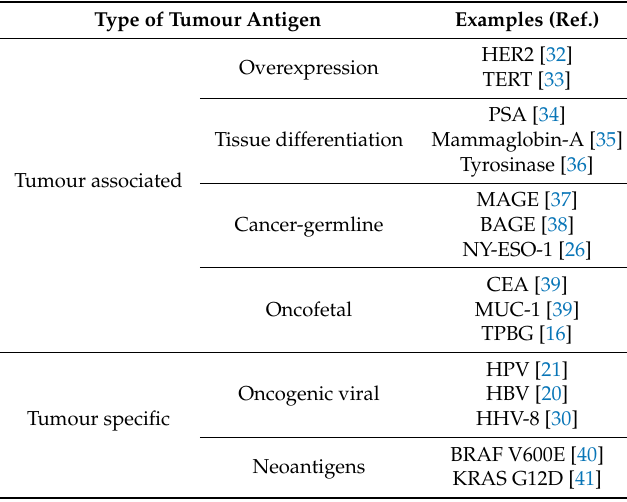
Table 1. Examples of tumour antigens and vaccine